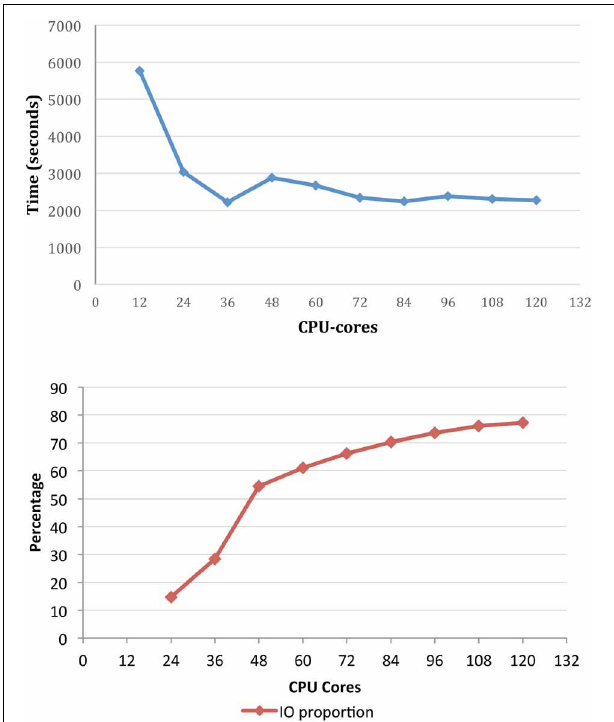
FIGURE 5 | The total reconstruction time for CT reconstruction of an 8912 3 dataset (top) and IO time as a proportion of runtime (bottom) on M1 as a function of the number of CPU